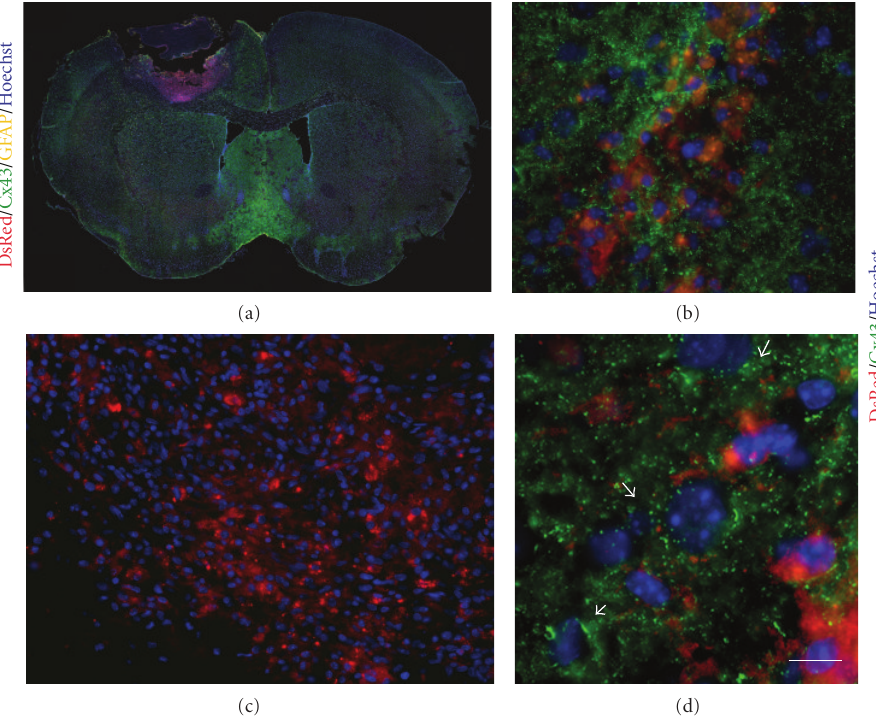
Figure 9: Gap junctions between AF cells and astrocytes following cell implantation into the injured motor cortex. (a) Stitched confocal image of mouse brain after motor cortex injury and receiving AF-DsRed (red) cell implant. Immunohistochemistry shows the distribution of Cx43 protein (green) at the interface between the graft and injured host tissue. (b) A higher magnification of the implant confirmed that AF- DsRed cells could be easily traced in the injured brain. (c)-(d) Intense Cx43 expression (green) was observed at the site of implantation. More specifically, distinct Cx43 immunostaining was detected at the junction between AF-DsRed (red) and cortical cells (see arrows). Hoechst was used as a counter stain (blue). All the sections were coronal. Scale bars: 1000 μ m (a), 100 μ m (b), 50 μ m (c), 7 μ m